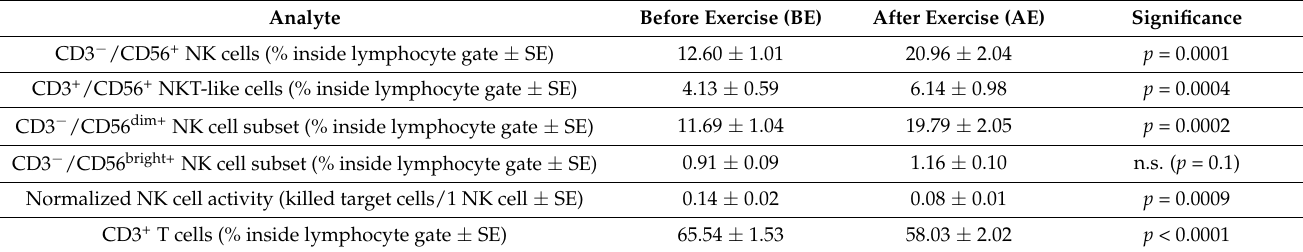
Table 1. Average ± SE values for the indicated percentage variables.